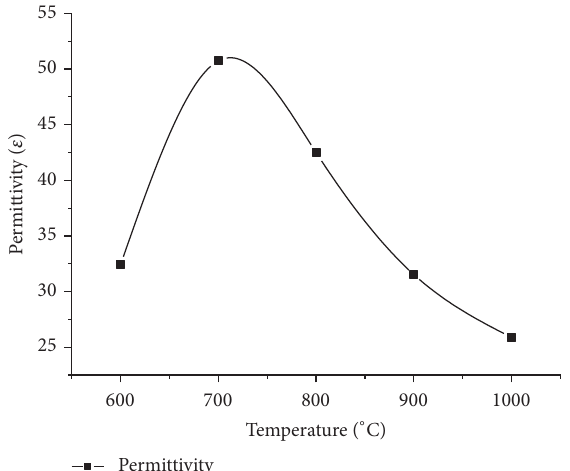
Figure 4: Effective carrier mobility versus inversion charge